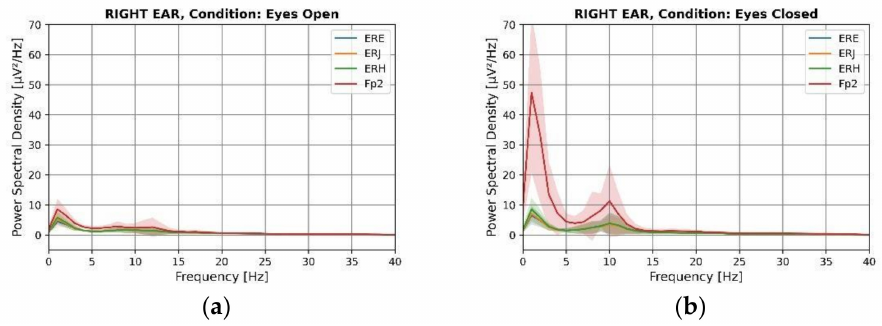
Figure 10. Power spectral density of electrodes for right ear measurements of eyes-open ( a ) and eyes-closed ( b )